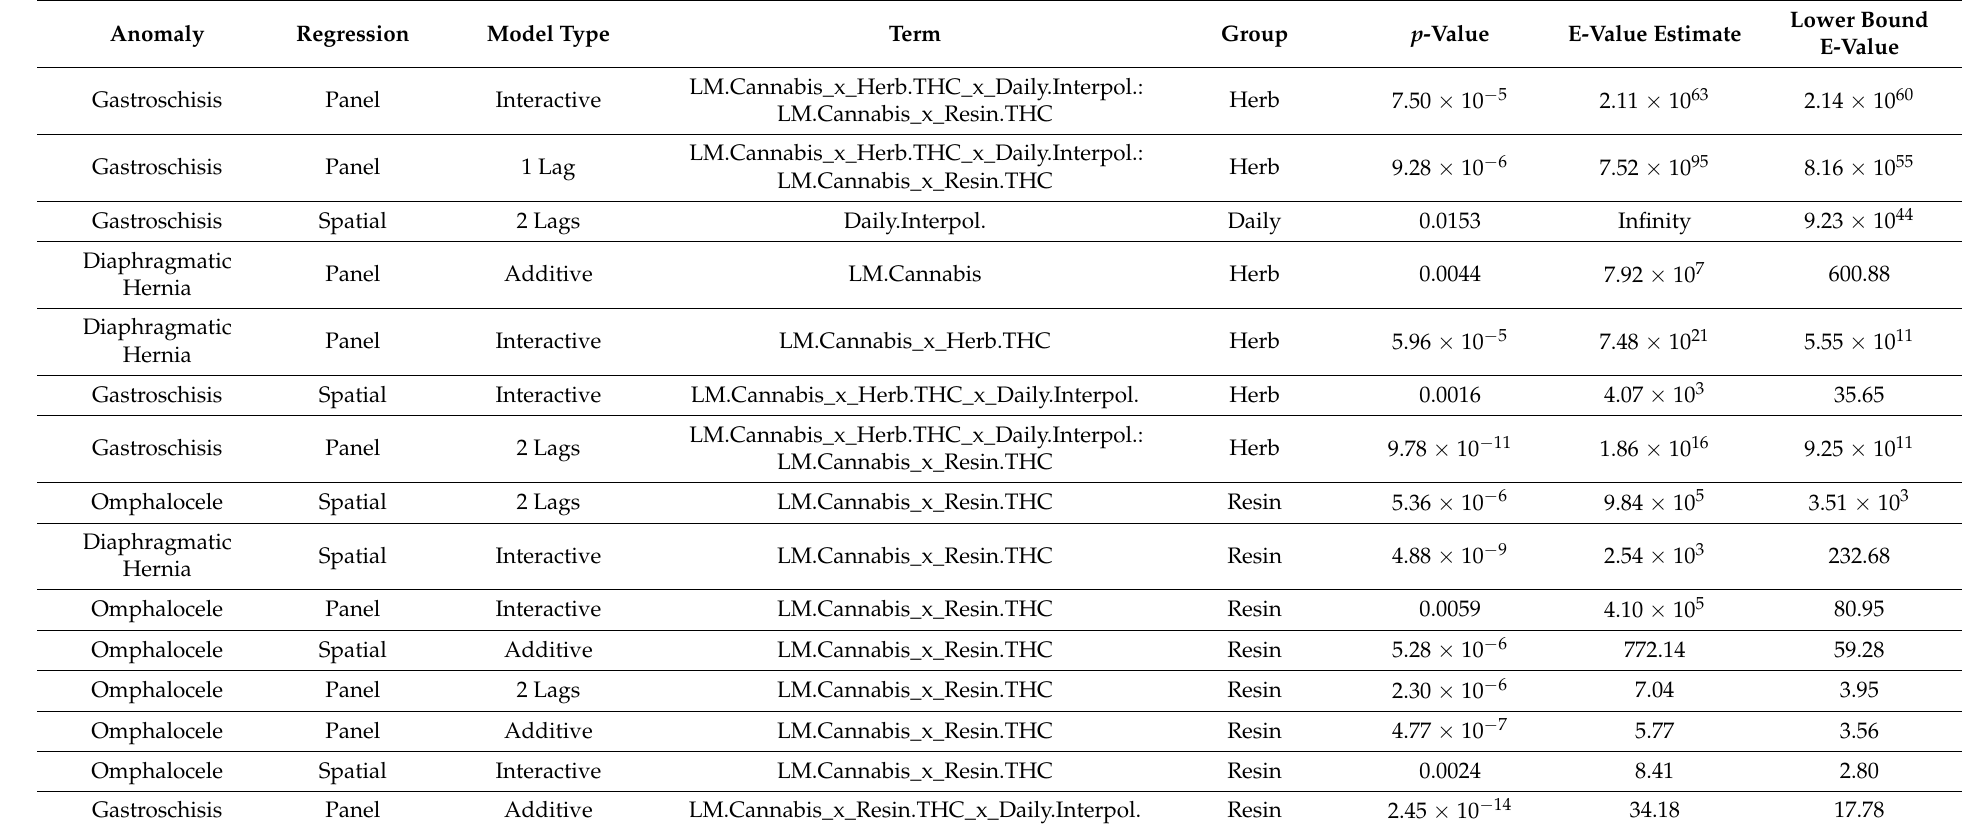
Table 11. E-Values by